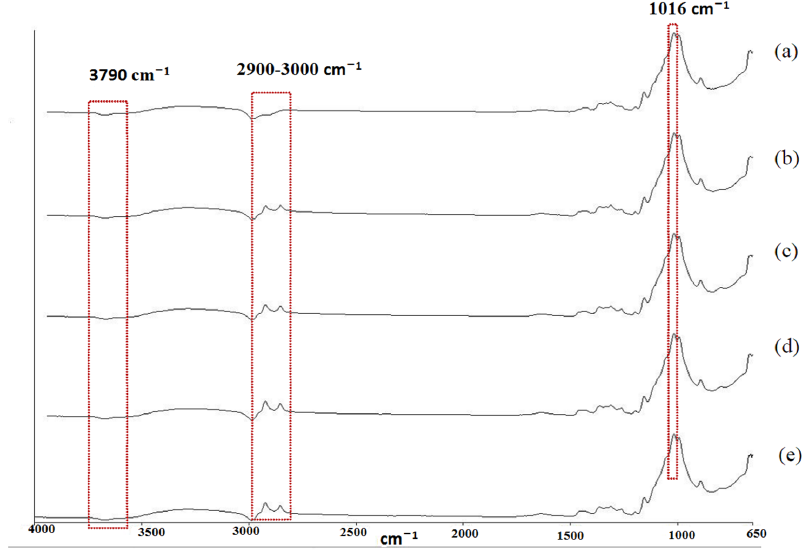
Figure 9. FTIR spectra of rayon flock synthetic leather after TMS plasma treatment with different discharge powers: ( a ) untreated, ( b ) 30 W, ( c ) 40 W, ( d ) 50 W, and ( e ) 60 W. (Amount of TMS = 0.2 mL; flow rate of helium = 12.5 LPM; jet distance = 10 mm, treatment time = 30 s.)